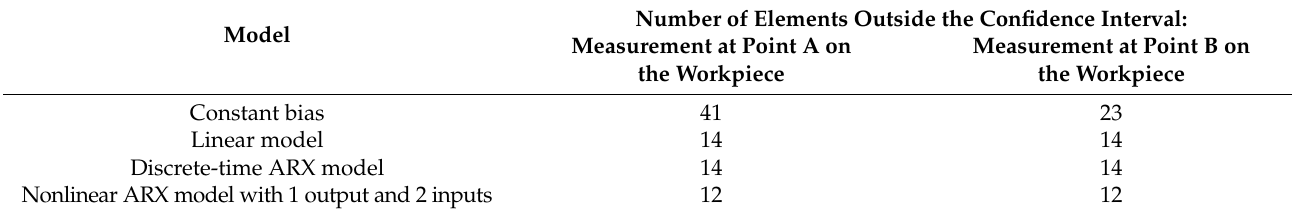
Measurement at Point B